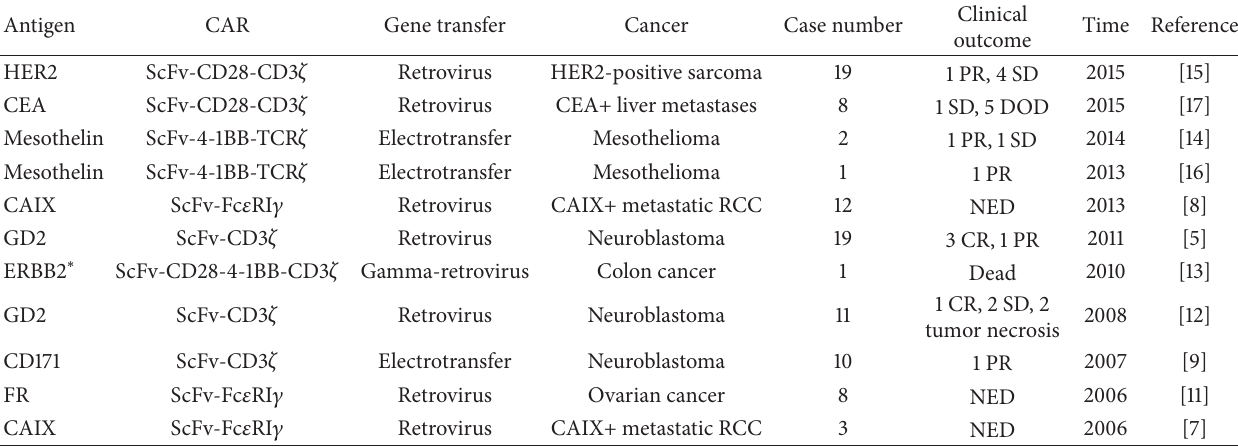
Table 1: Recent published clinical studies on CART cells specific for solid tumor